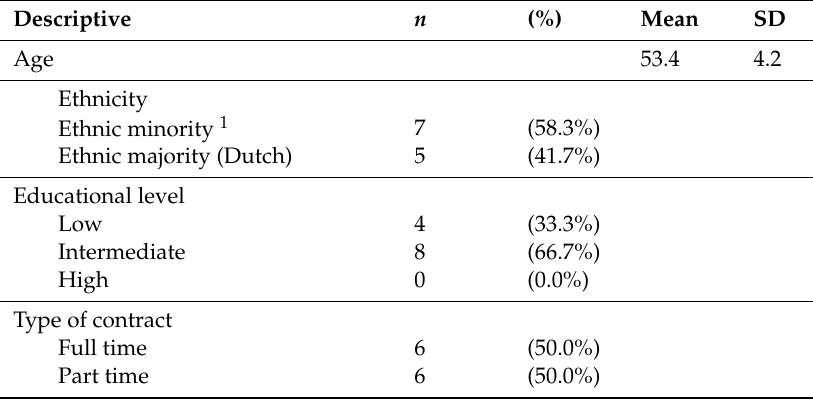
Table 4. Characteristics of interview participants ( n =